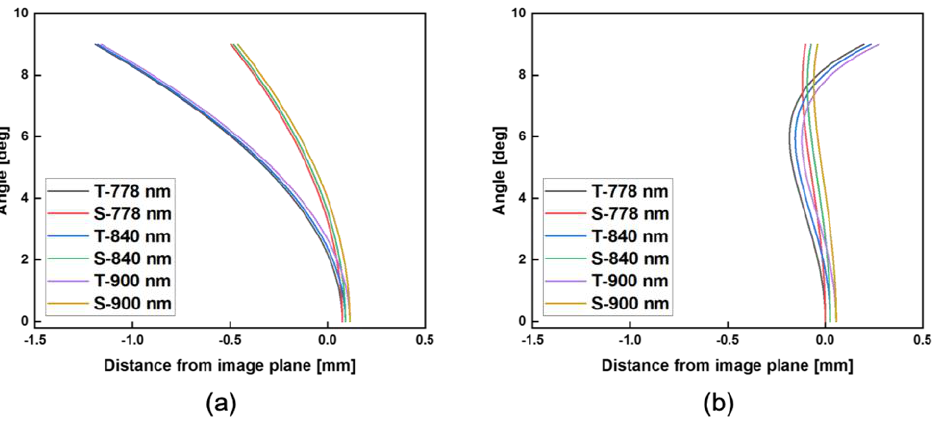
Figure 2. The field curvature and astigmatic aberration characteristics of each imaging lens. T and S mean the tangential and sagittal focal position of ( a ) the achromatic doublet lens (ADL) and ( b ) the telecentric f-theta lens (TFL).